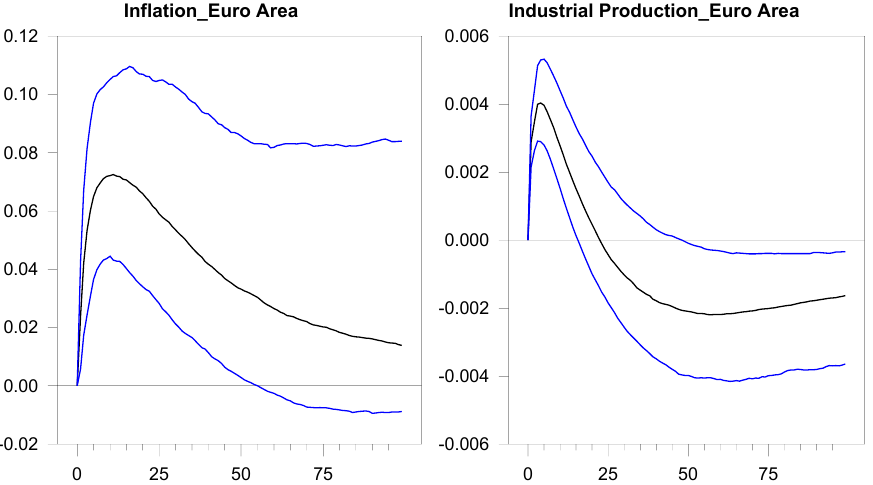
Figure 5. Responses of Euro Area inflation and industrial production to a contractionary monetary policy shock. Monetary policy shock identified as exogenous innovation to European Overnight Average Interest Rate (EONIA). Error bands set at the 10th and the 90th percentiles.